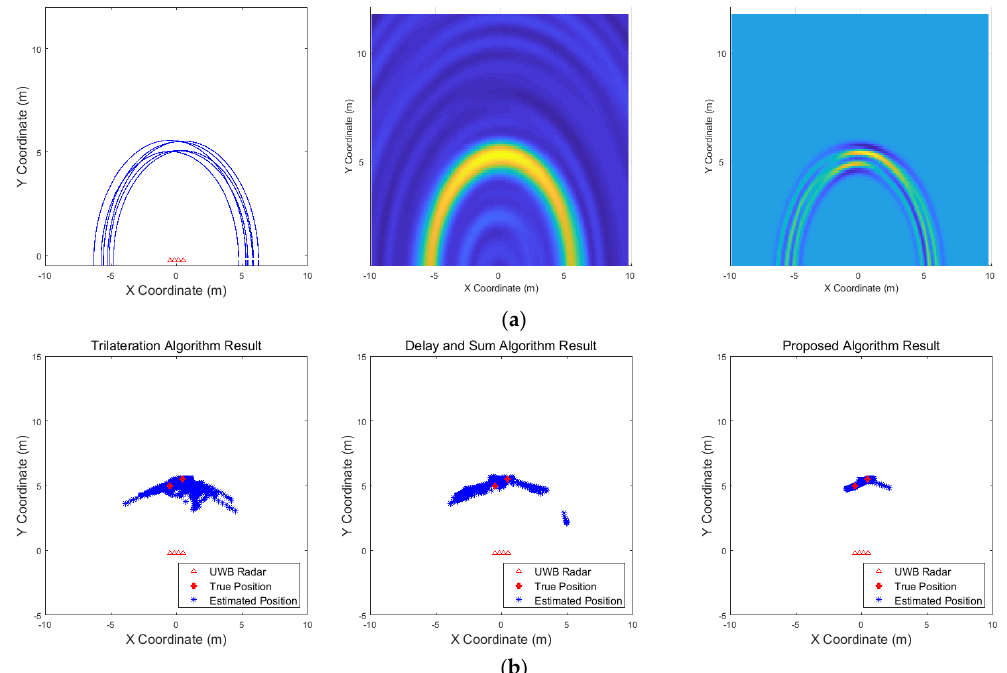
Figure 12. Simulation results when two targets stand close each other (Scenario 4): ( a ) instantaneous results of position estimation step according to the positioning algorithm; ( b ) results of the radar system for the entire simulation.